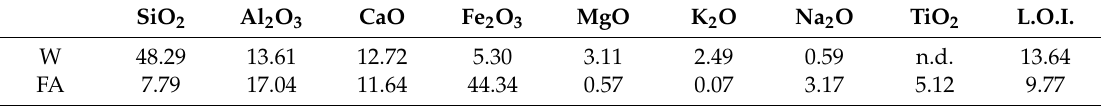
Table 1. Chemical analysis of raw materials (in wt%). W: clay mixture and FA: ferroalumina. SiO